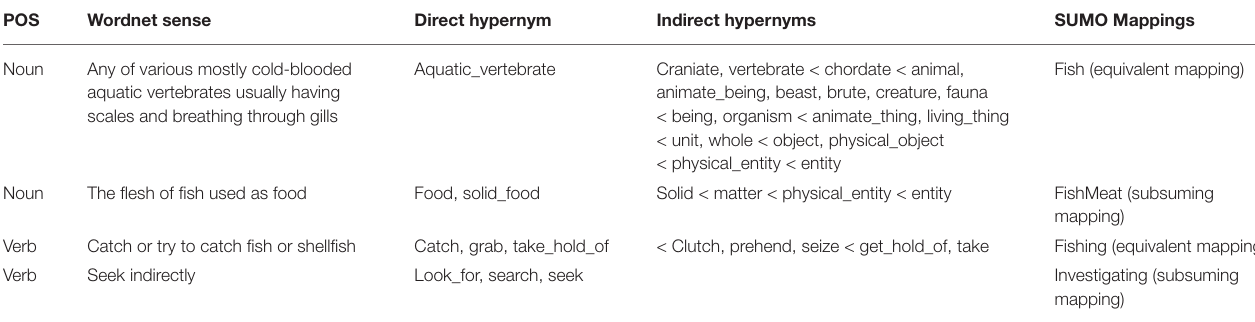
TABLE 1 | WordNet senses with SUMO mappings for the noun and verb “fish.”